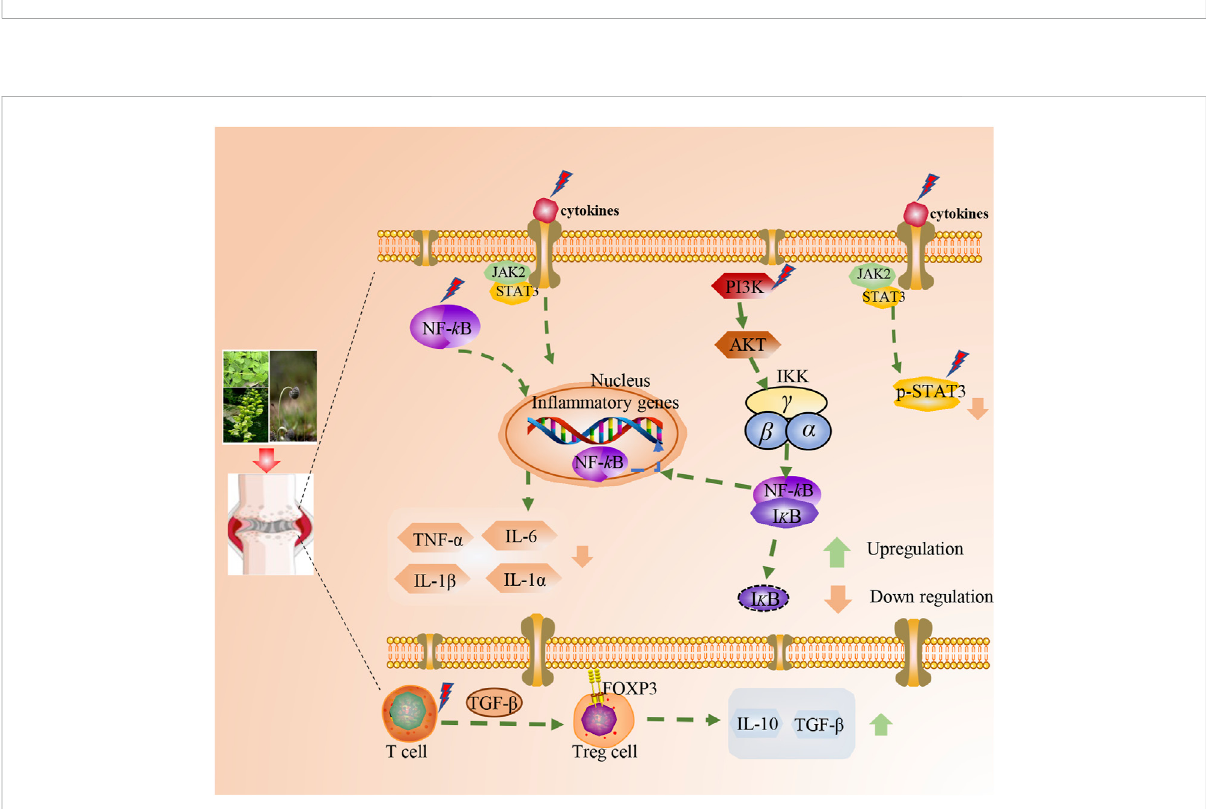
FIGURE 5 Anti-RA mechanism classi fi cation of main TTM active components by anti-in fl